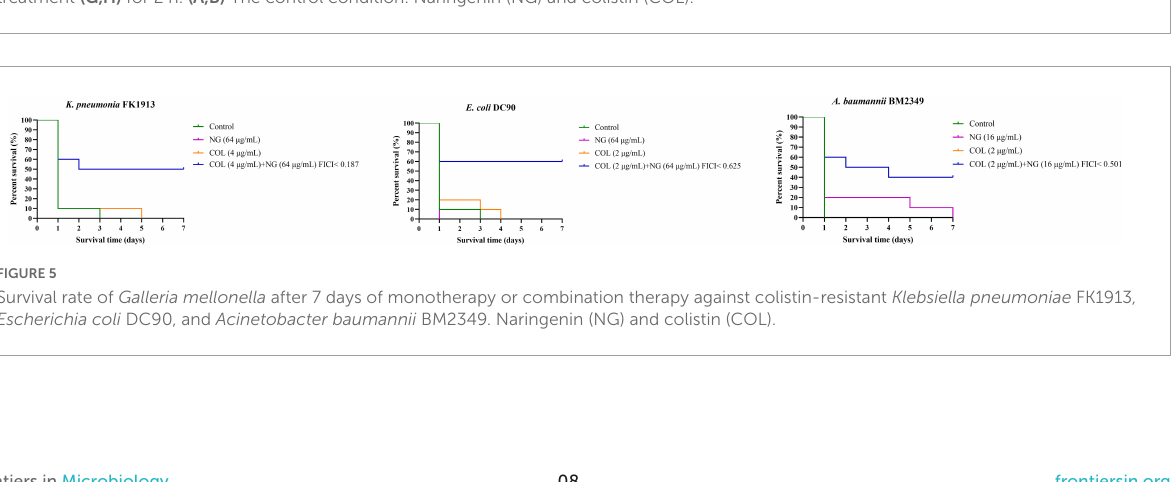
FIGURE4 Scanning electron microscopy image. Klebsiella pneumonia FK1913 treated with 64 µ g/ml naringenin (C,D) , 2 µ g/ml colistin (E,F) , or combined treatment (G,H) for 2 h. (A,B) The control condition. Naringenin (NG) and colistin (COL).